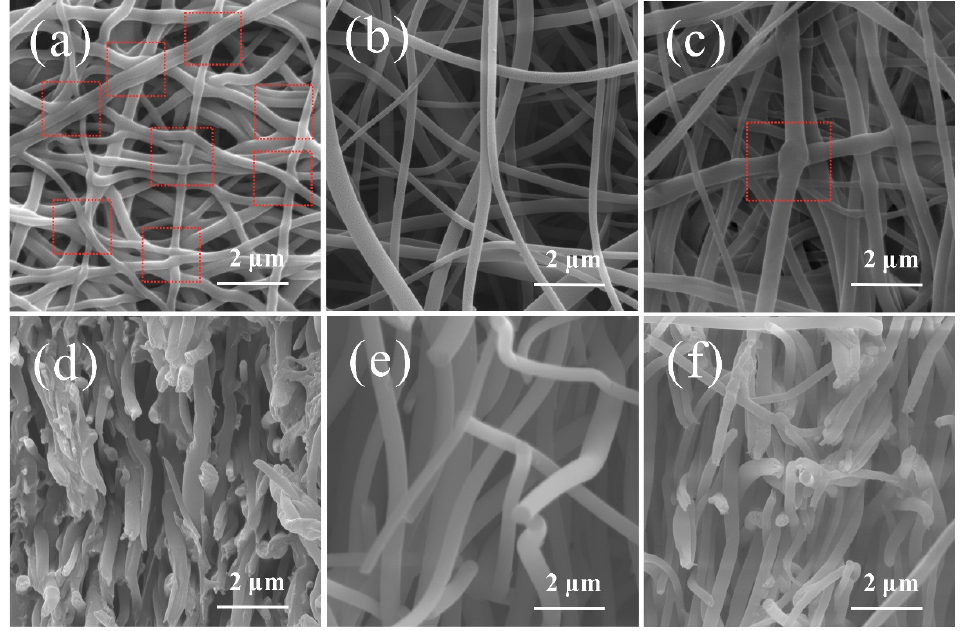
Figure 4. Surface and cross-section morphologies of ( a , d ) CNMs-CC, ( b , e ) CNMs, and ( c , f ) CNMs-PC.